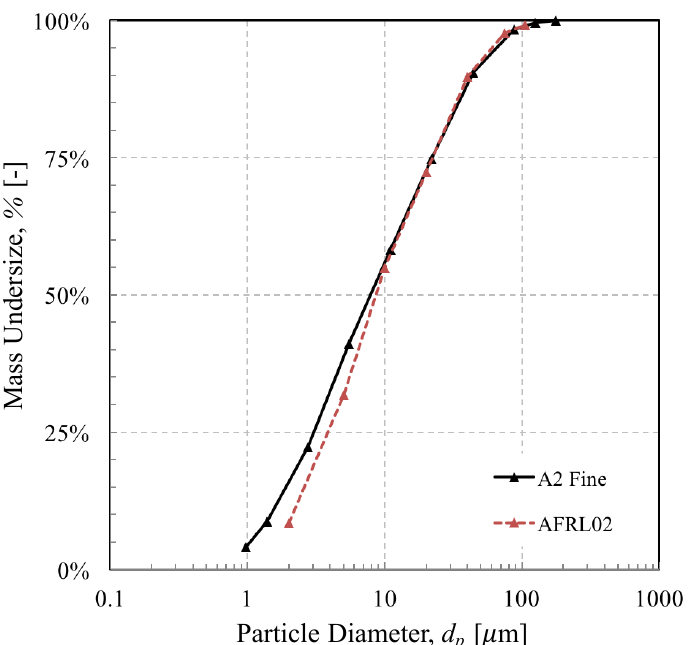
Figure 7. Cumulative distribution of the two mineral dusts